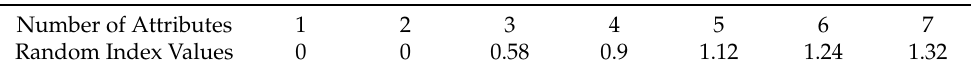
Table 5. The utilized Random Index (RI) values in the AHP. Number of